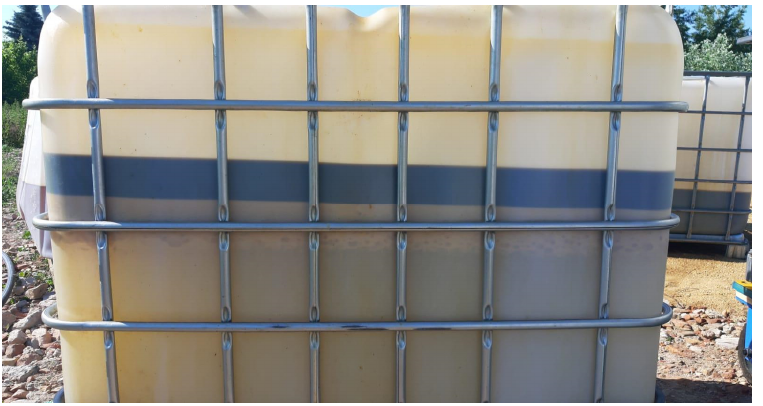
Figure 6. Separation of the emulsion after passage through the non-saturated zone and pumping off to the ground: The top layer is a mix of plant oil and mineral oil washed out from the soil. The main experiments carried out in the non-saturated zone during the field trials are tabulated in Table 6: Table 6. Flushing and pumping trials in the non-saturated zone.